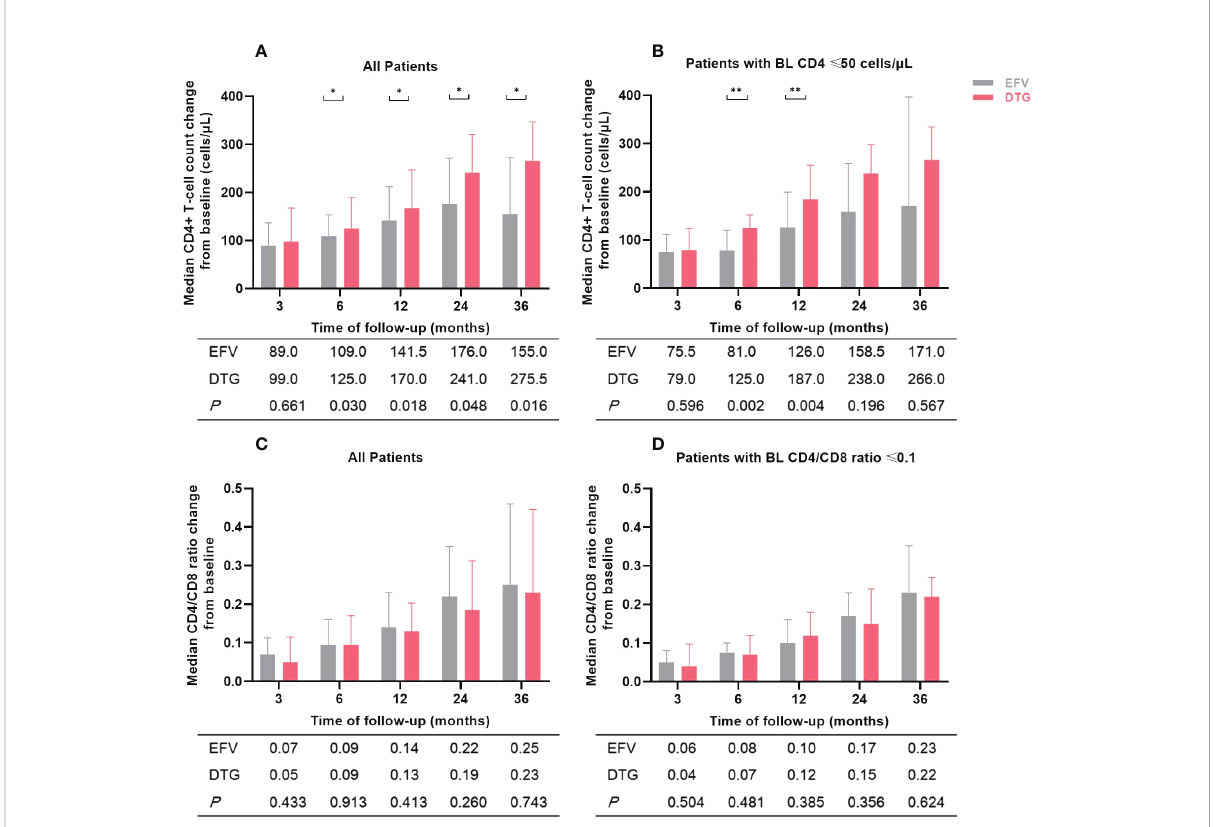
FIGURE 3 Changes in median CD4+ T-cell count and CD4/CD8 ratio of patients during the follow-up period according to antiretroviral regimens. (A) Median CD4+ T-cell count change from baseline in all patients. (B) Median CD4+ T-cell count change from baseline in patients with baseline CD4+ T-cell count ≤ 50 cells/ m L. (C) Median CD4/CD8 ratio change from baseline in all patients. (D) Median CD4/CD8 ratio change from baseline in patients with baseline CD4/CD8 ratio ≤ 0.1. The numbers in the table below the fi gure were the median change of CD4+ T-cell count or CD4/CD8 ratio from baseline. BL, baseline; EFV, efavirenz; DTG, dolutegravir. *P<0.05;